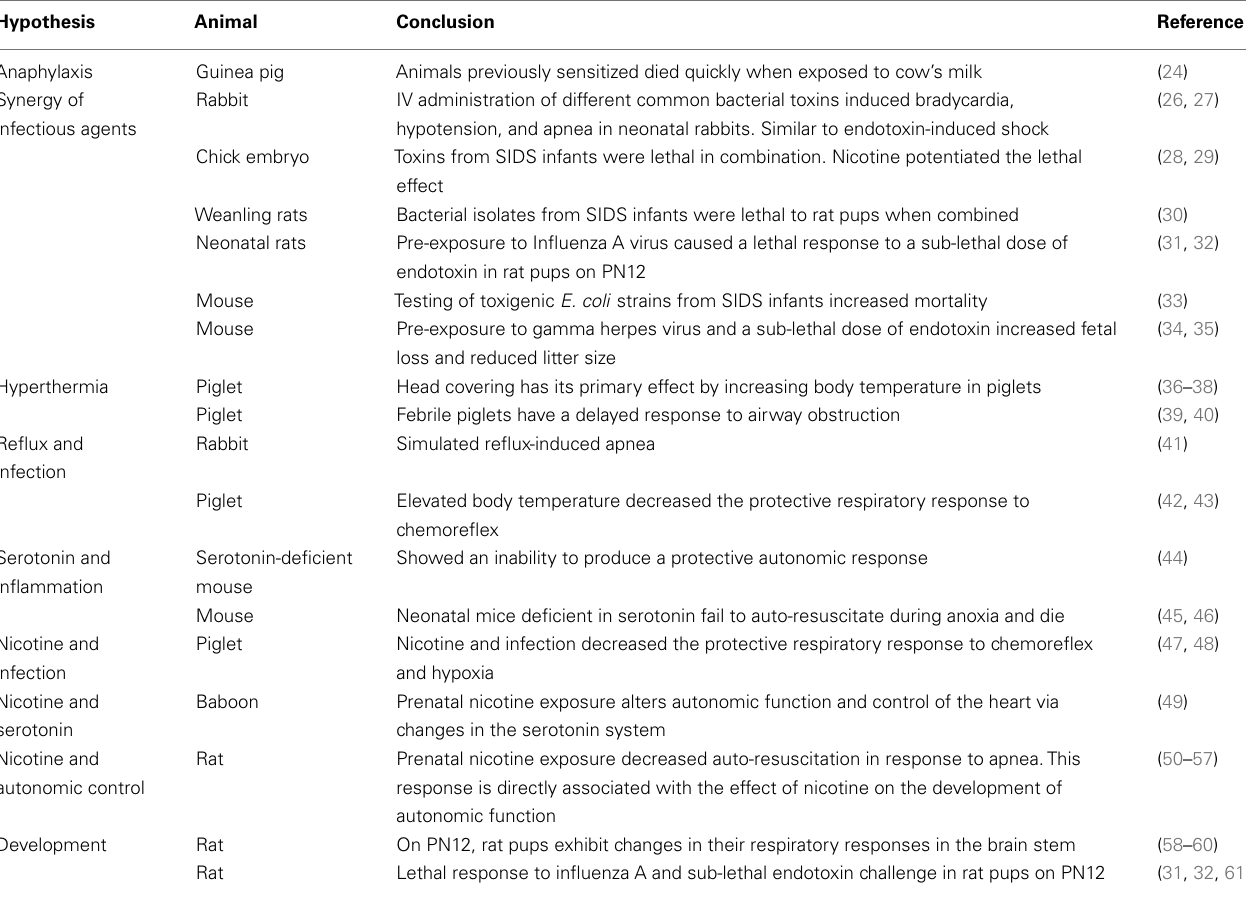
Table 1 |Animal models examining hypotheses to explain SIDS